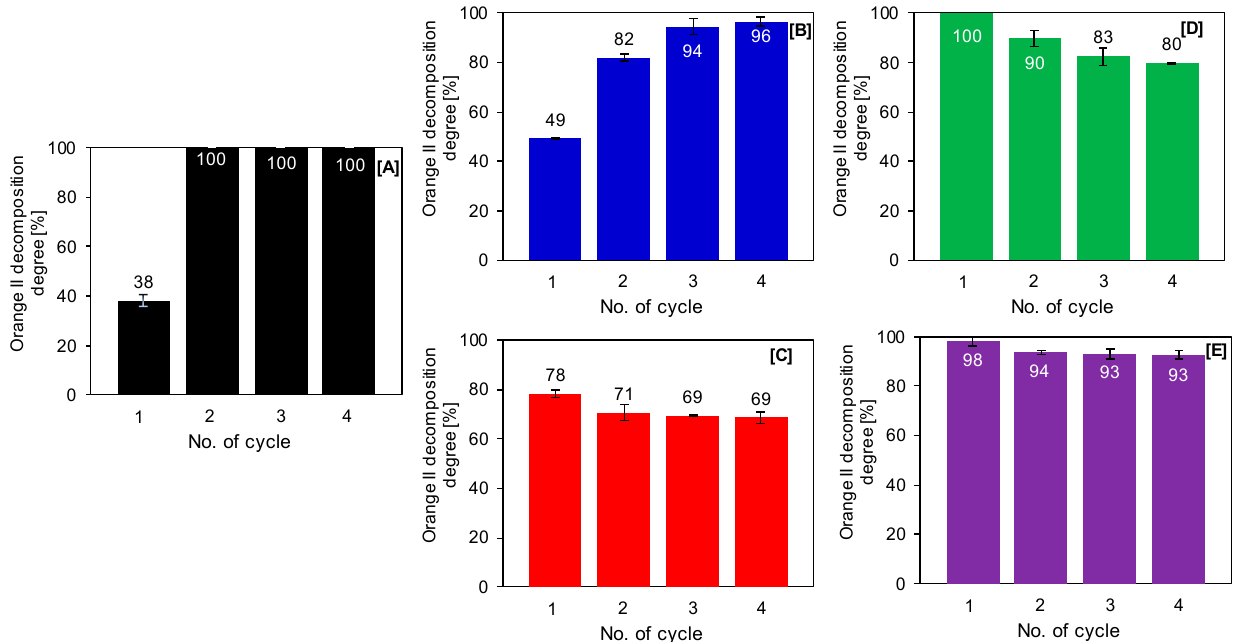
Figure 12. Photocatalytic activity in subsequent cycles of Orange II degradation of TiO 2 -4h–120 ◦ C–500mM ( A ), TiO 2 –4h– 120 ◦ C–500mM-Ar-300 ◦ C ( B ), TiO 2 –4h-120 ◦ C–500mM-Ar-500 ◦ C ( C ), TiO 2 –4h–120 ◦ C–500mM-Ar–700 ◦ C ( D ), and TiO 2 -4h– 120 ◦ C–500mM-Ar-900 ◦ C ( E )